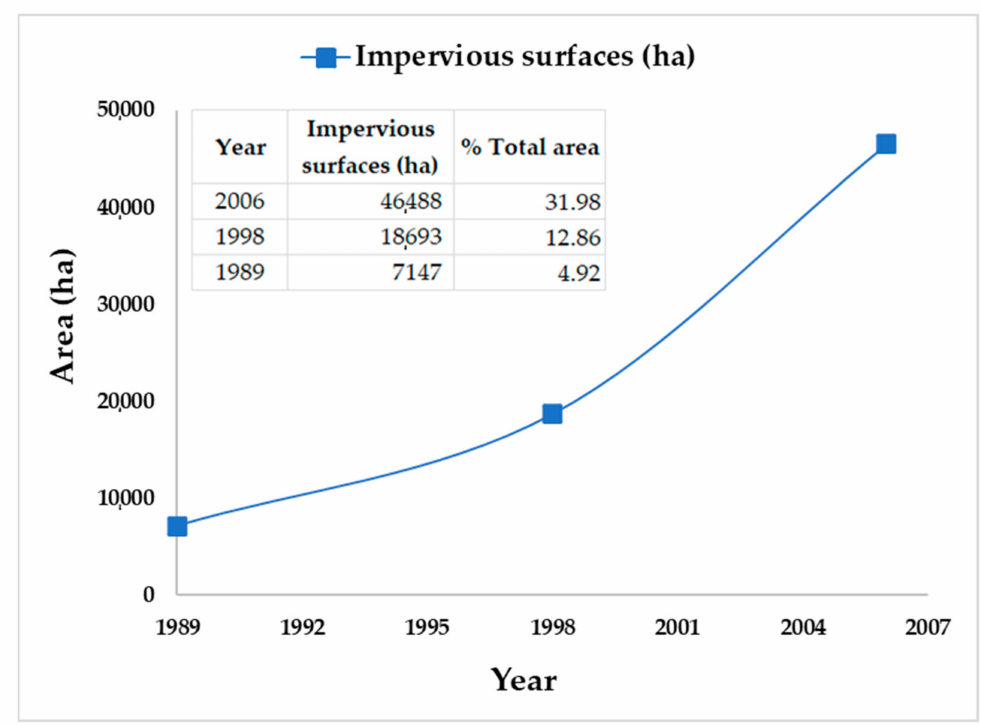
Figure 7. Imperious surface change in Ho Chi Minh city over the period 1989–2006 adopted from Van and Bao [73].